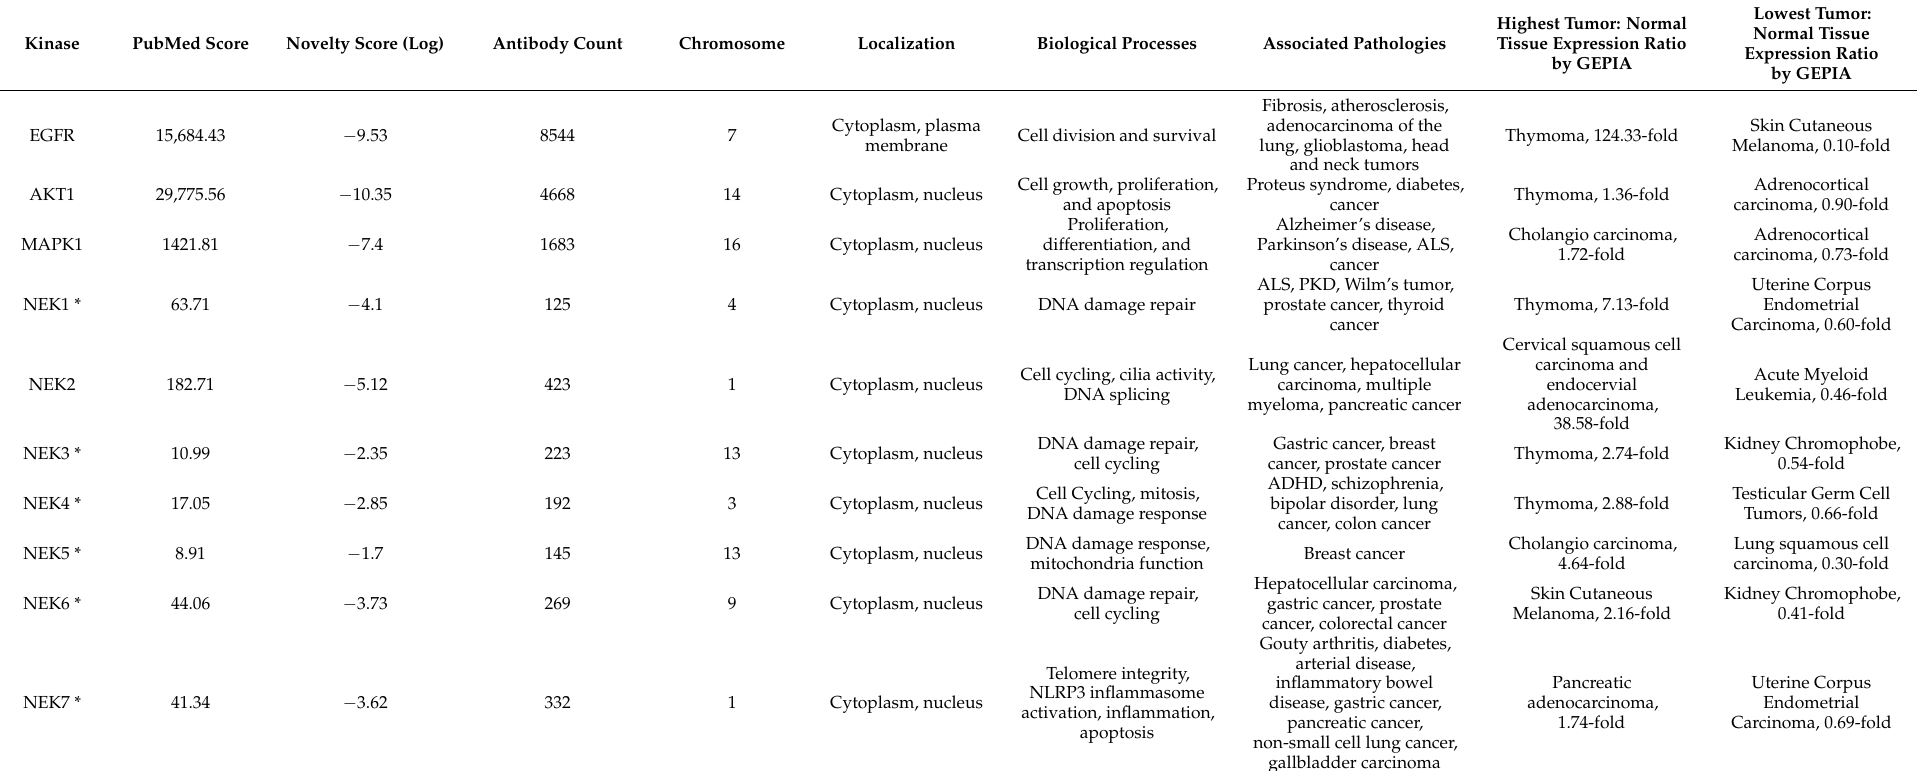
Table 2. Scores from Pharos, the user interface to the Knowledge Management Center (KMC) for the Illuminating the Druggable Genome (IDG) program funded by the National Institutes of Health (NIH) Common Fund. EGFR, AKT1, and MAPK1 are included as better studied molecules for comparison with the NEK family of kinases. The PubMed score is described as “Jensen Lab generated fractional counting score for the prevalence of this target in PubMed articles”. The log Novelty Score is described as “TIN-X metric for the relative scarcity of specific publications for this target”. The Antibody Count is described as “Number of antibodies for this target listed in antibodypedia.com”. NEKs with an asterisk (*) denote 2021 (RFA-RM-21-012) NIH designated understudied kinases. Furthermore, this table contains a summary of information on each kinase member, including expression level comparisons between tumor and normal tissues from the GEPIA database (Supplementary Figure